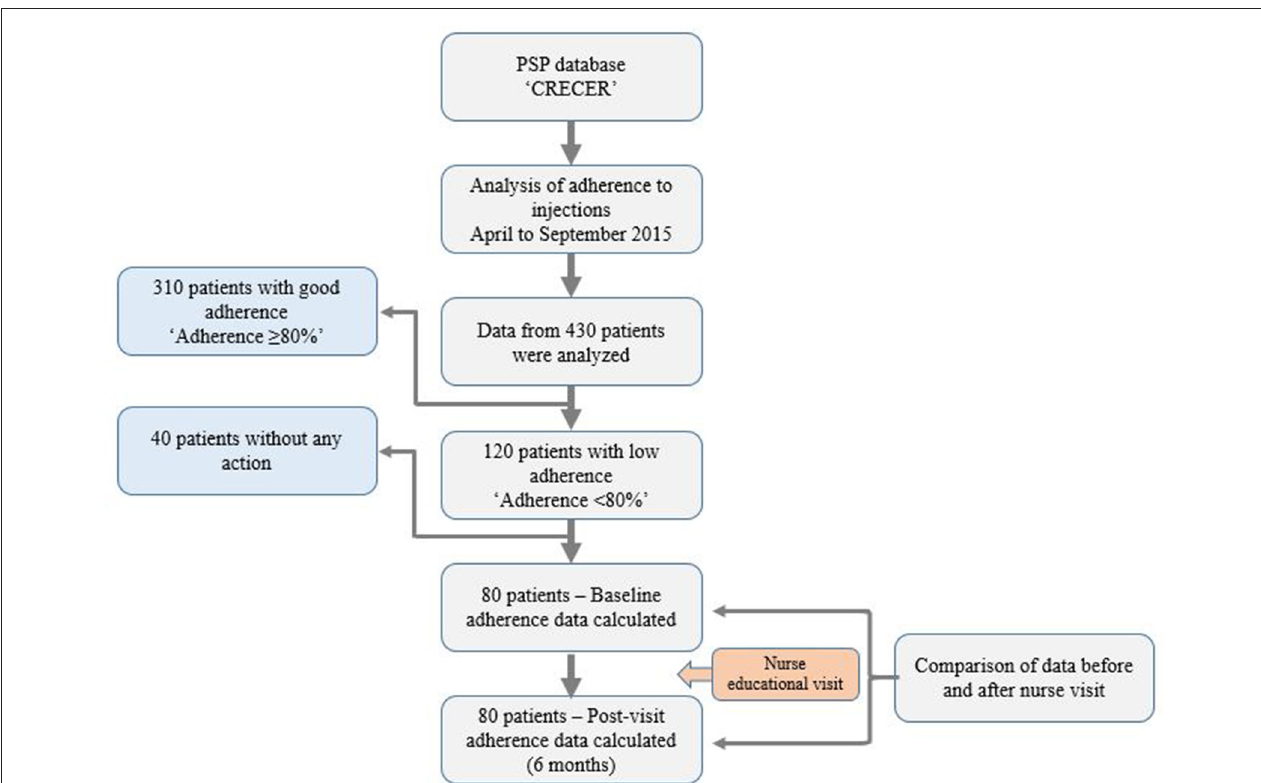
FIGURE 1 | CONSORT style flow chart of study procedures.